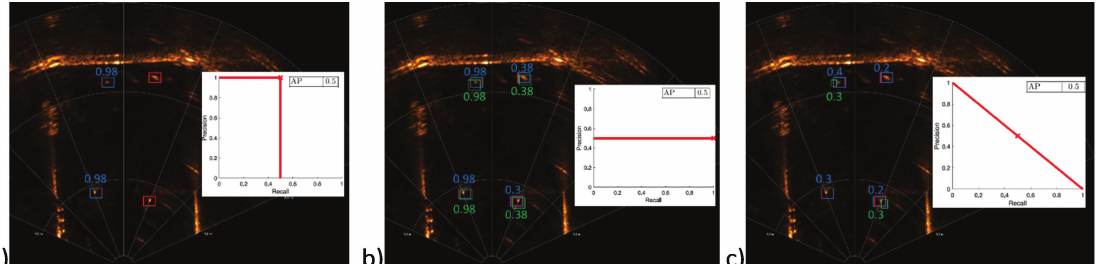
Figure 6. Object detection results with very different Recall–Precision (RP) curves but the same average precision (AP). ( a ) low recall–high-precision with only half detections but at maximum precision. In ( b ) all reflectors are identified with average precision and ( c ) shows high precision at low recall and low precision at high